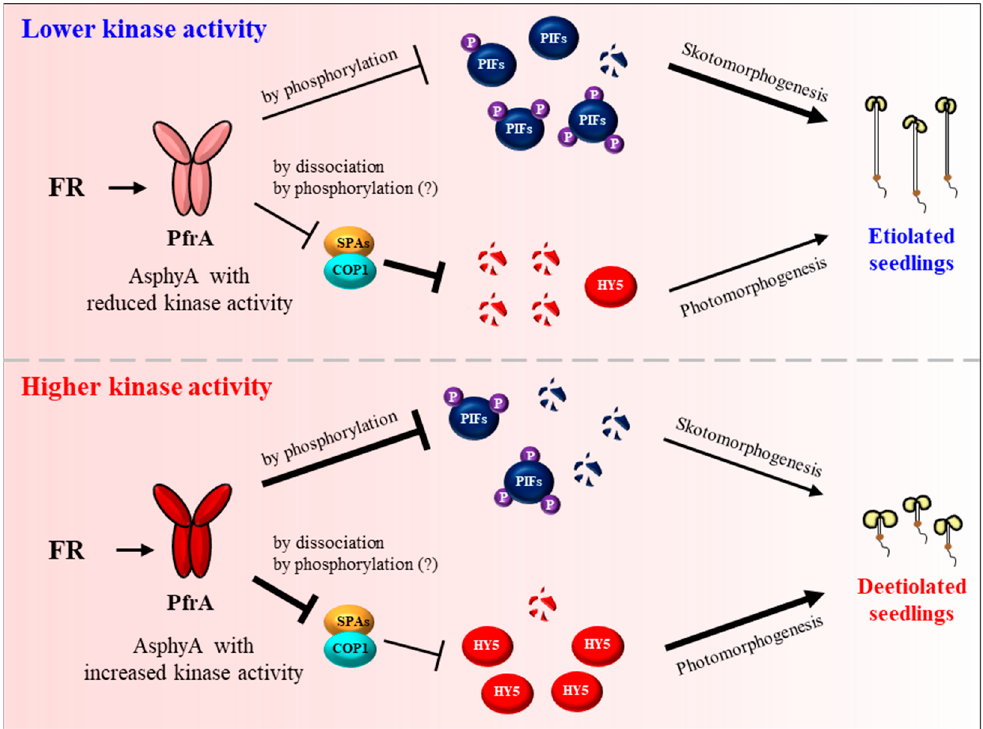
Figure 4. A model depicting phyA signaling as a protein kinase in response to FR light. This model is constructed using the results of AsphyA mutants with lower or higher kinase activity. Based on the core phytochrome signaling pathway, far-red (FR) light-activated phyA (PfrA) phosphorylates PIFs (labeled ⓟ in purple), which induces subsequent degradation via the ubiquitin/26s pro- teasome pathway. At the same time, PfrA induces the dissociation of COP1/SPA complex, resulting in the accumulation of HY5. Thus, the negative regulation of PIFs and COP1/SPA complex by phyA resultantly contributes to HY5 accumulation, which is necessary for photomorphogenic develop- ment such as de-etiolation of seedlings. According to this model, AsphyA with reduced kinase ac- tivity might exhibit an attenuated function (i.e., approximately 2-fold decreases in phosphorylation of PIFs and dissociation of the COP1/SPA complex, represented as thin lines), showing reduced responses of transgenic plants to FR light (i.e., etiolated seedlings). On the other hand, AsphyA with increased kinase activity could show an enhanced function, which results in about 4-fold higher accumulation of HY5 (represented as thick lines), exhibiting increased FR-responses of transgenic plants (i.e., de-etiolated seedlings). It is noted that other protein kinases are also involved in the phosphorylation of PIFs, and possibly PfrA is involved in the phosphorylation of COP1 (see the